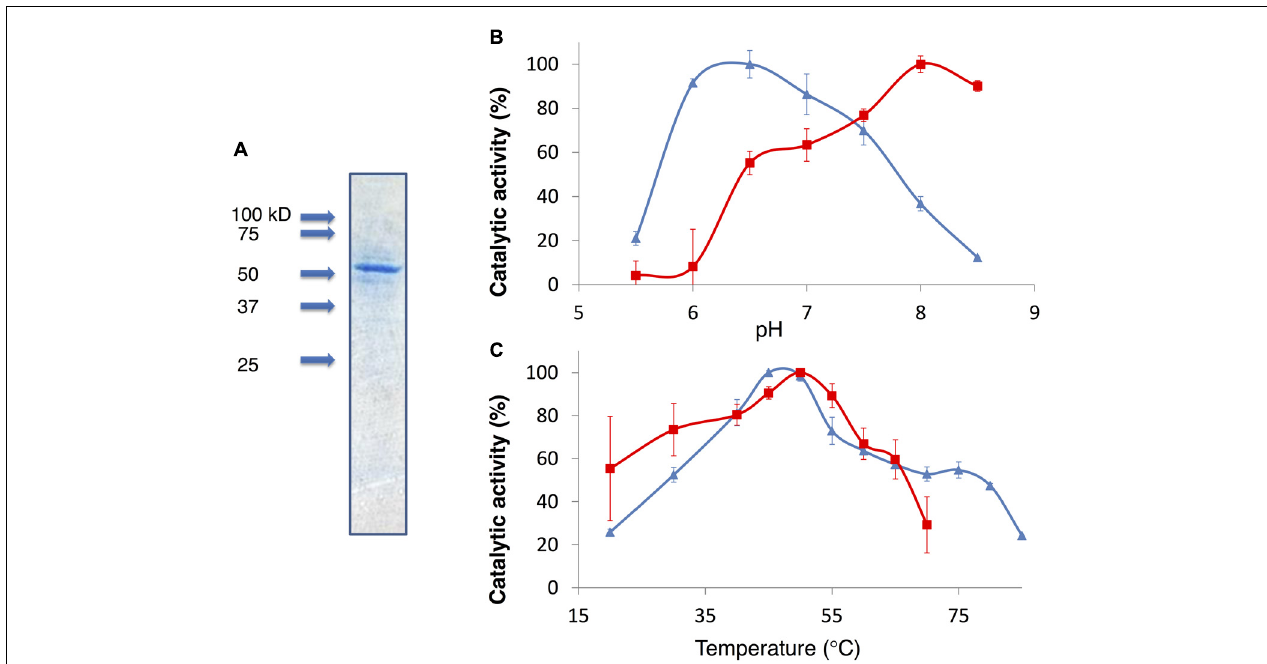
FIGURE 1 | (A) Purification of GST-tagged Sy MDH. Proteins were electrophoresed on a 12% SDS-PAGE gel. The gel was stained with InstantBlue. Arrowheads indicate the molecular weight. (B) The effect of pH on Sy MDH activity. Red square represents the specific activity in the oxidative reaction (malate to oxaloacetate). Blue triangle represents the specific activity in the reductive reaction (oxaloacetate to malate). Data represent the relative values of the mean from three independent experiments. (C) The effect of temperature on Sy MDH activity. Red square represents the specific activity in the oxidative reaction (malate to oxaloacetate). Blue triangle represents the specific activity in the reductive reaction (oxaloacetate to malate). Data represent the relative values of the mean from three independent experiments.